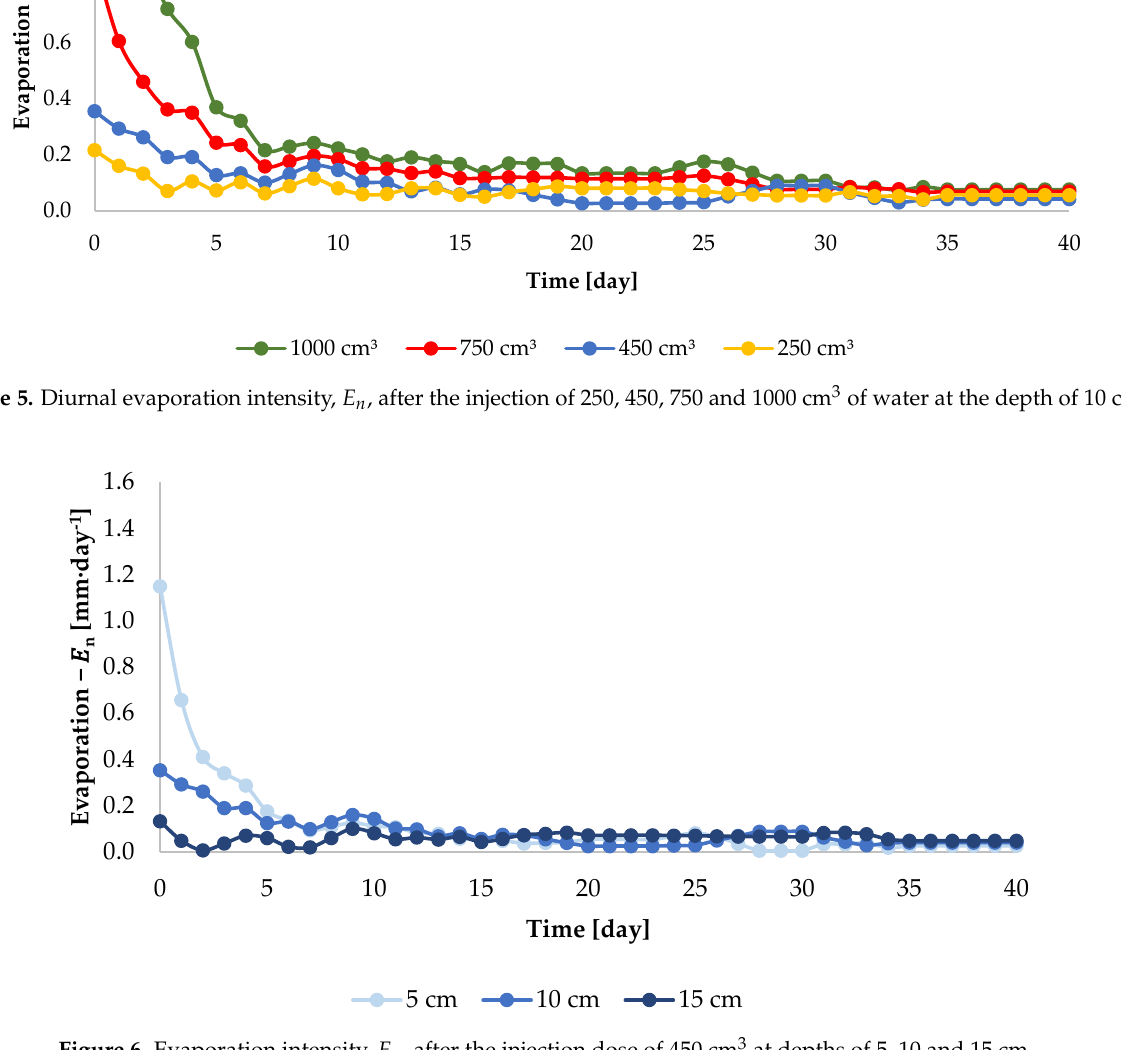
1000 cm³ 750 cm³